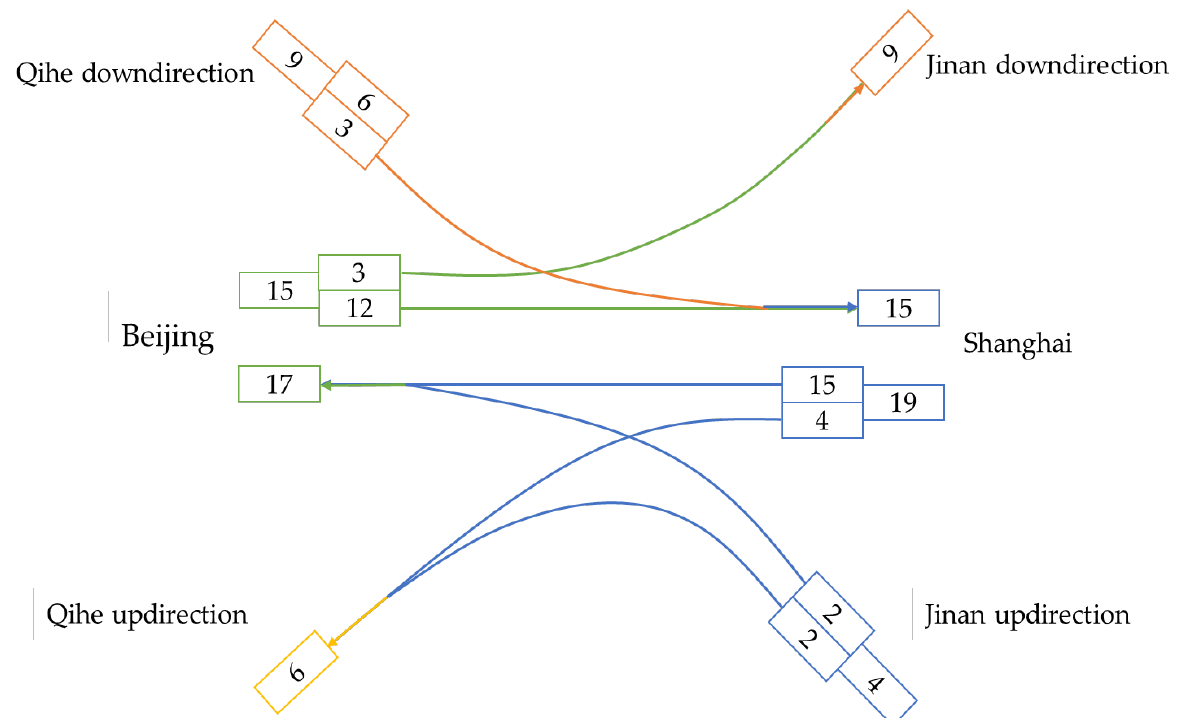
Figure 5. The composition of station capacity in scenario 2 (120min). Table 4. Result of scenario 1.